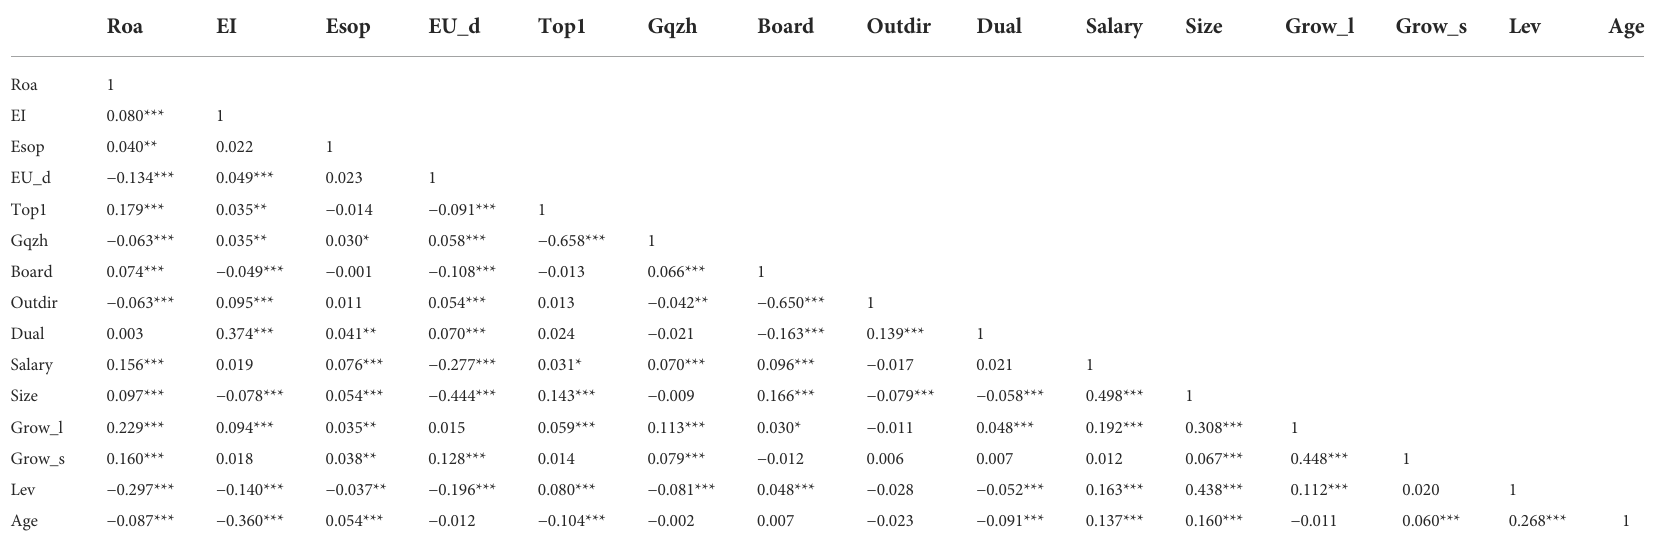
TABLE 3 Correlation coef fi